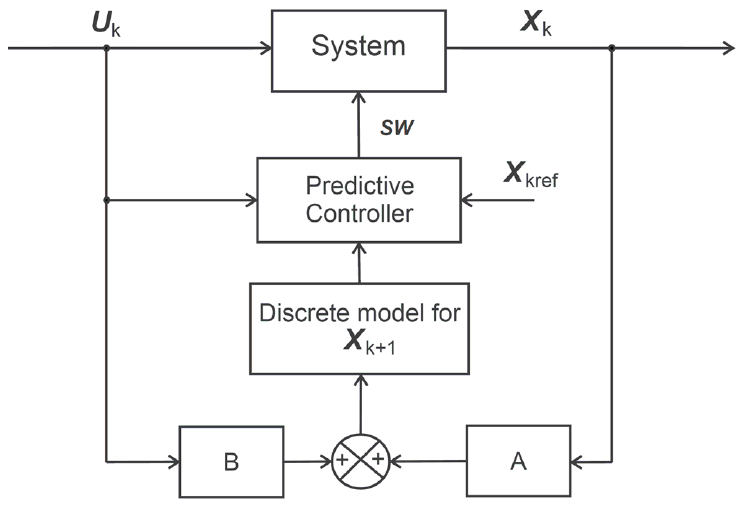
Figure 2. General control scheme for predictive control.